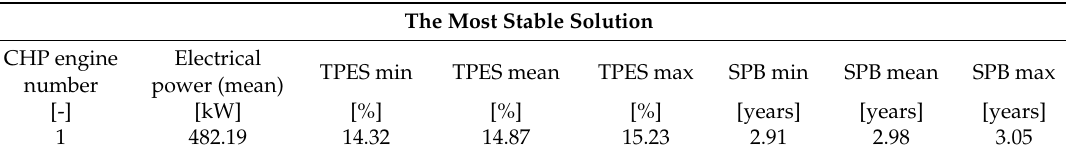
Table 3. The main characteristics of the most stable